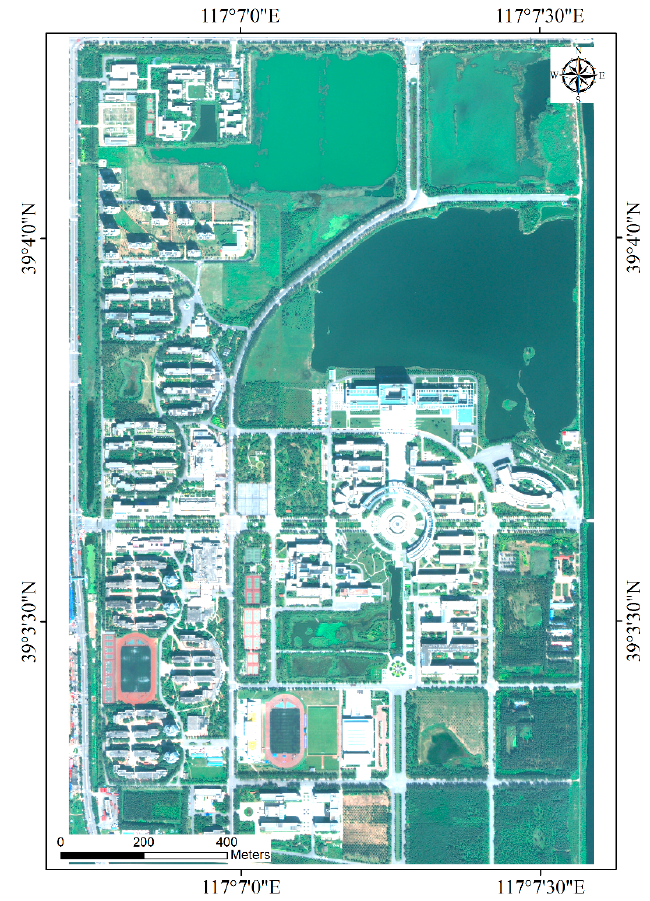
Figure 5. The study area based on natural color composite imagery using bands 5, 3, and 2 for RGB.